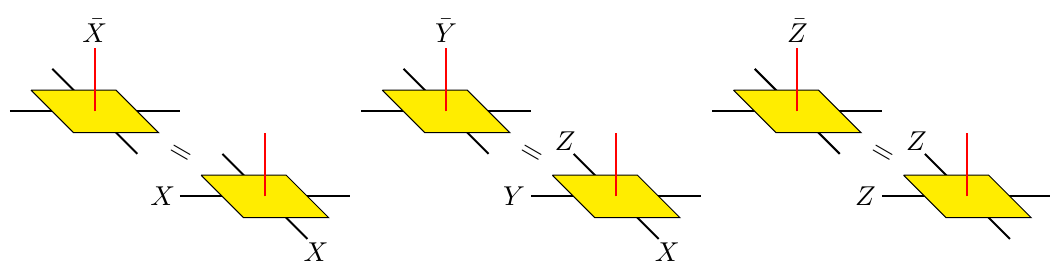
Figure 8. The logical Pauli operators can be “pushed” to the in-plane legs in the tensor network representation. Here we have “cleaned” the rightmost leg – all logical operations act trivially on this